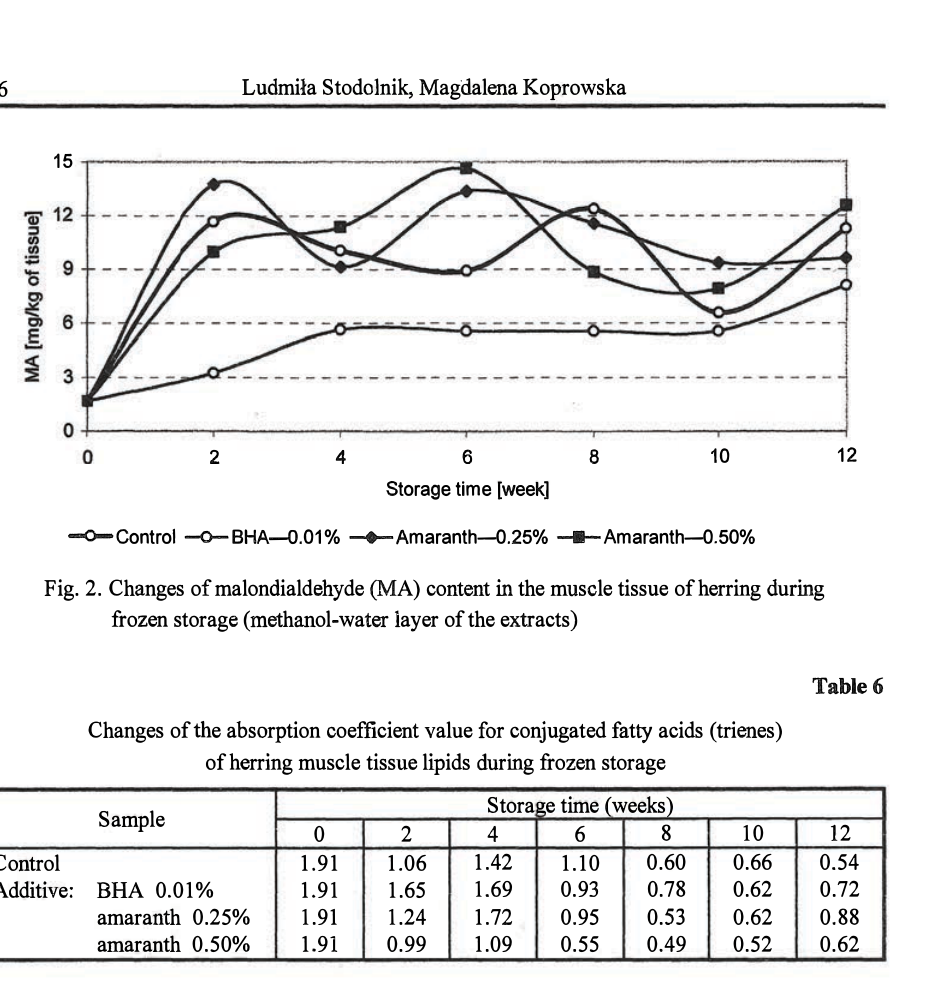
Fig. 2. Changes of malondialdehyde (MA) content in the muscle tissue of herring during frozen storage (methanol-water layer of the